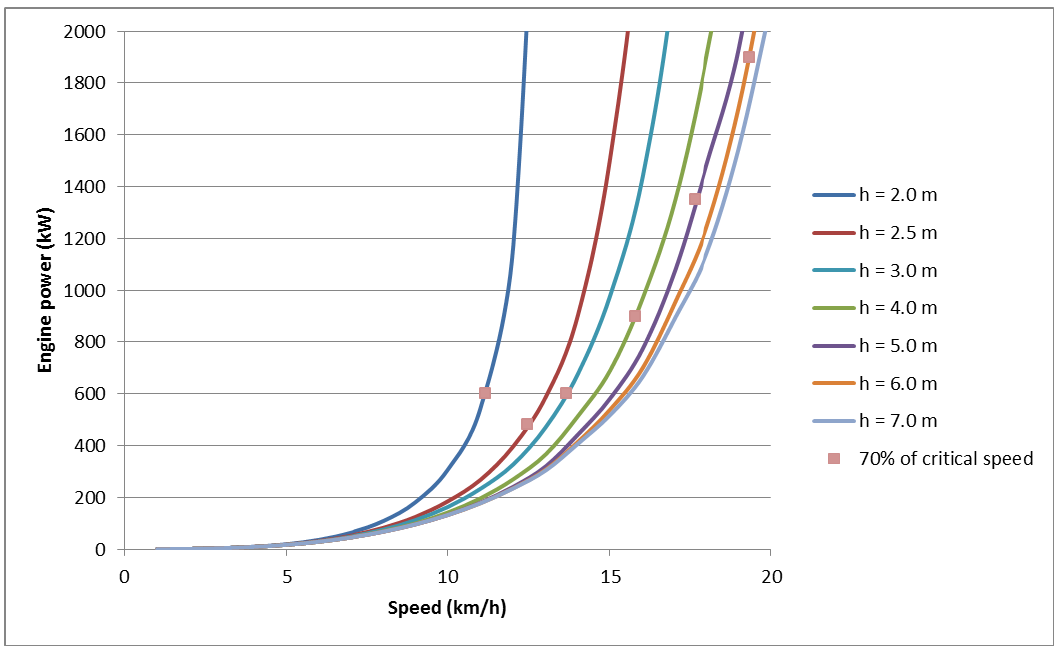
Figure 3. Calculated Speed-power curves of